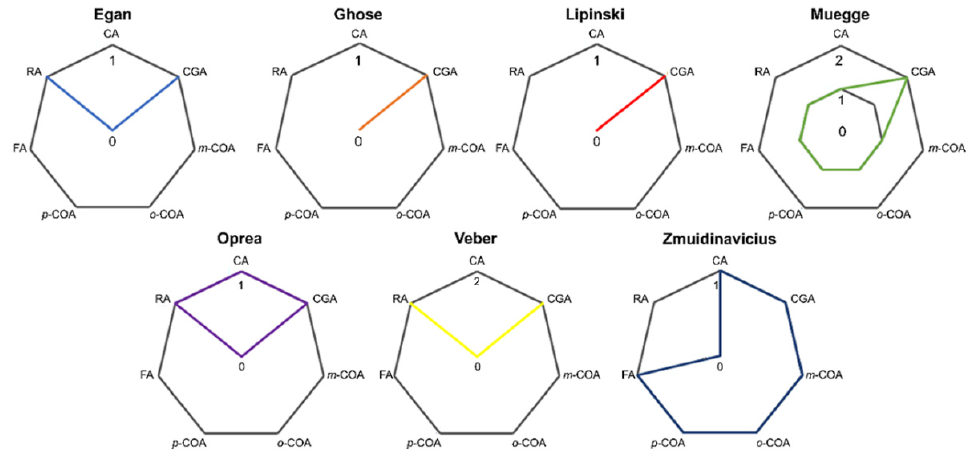
Figure 2. Number of violations for HCAs in each prediction rule.